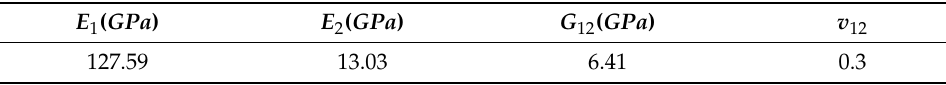
Table 1. Graphite-epoxy lamina’s properties.